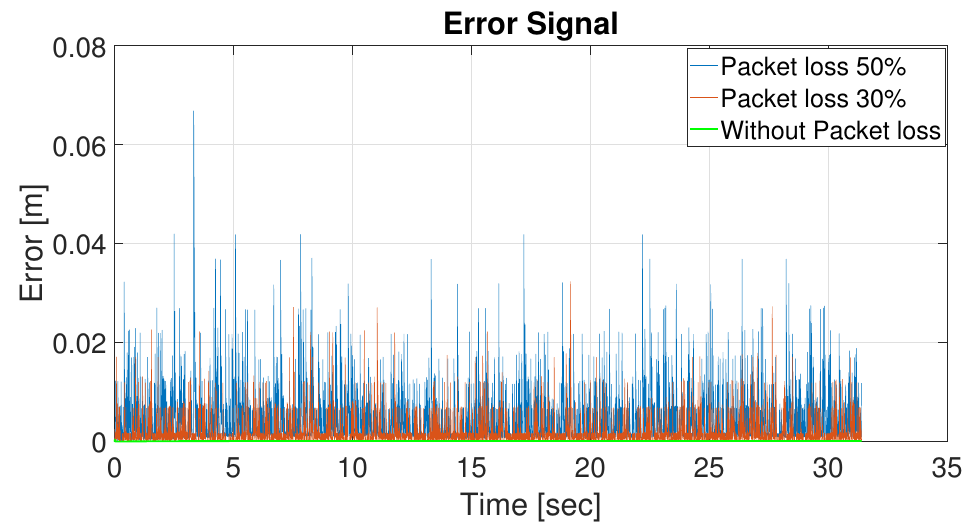
Figure 3. Effect of packet